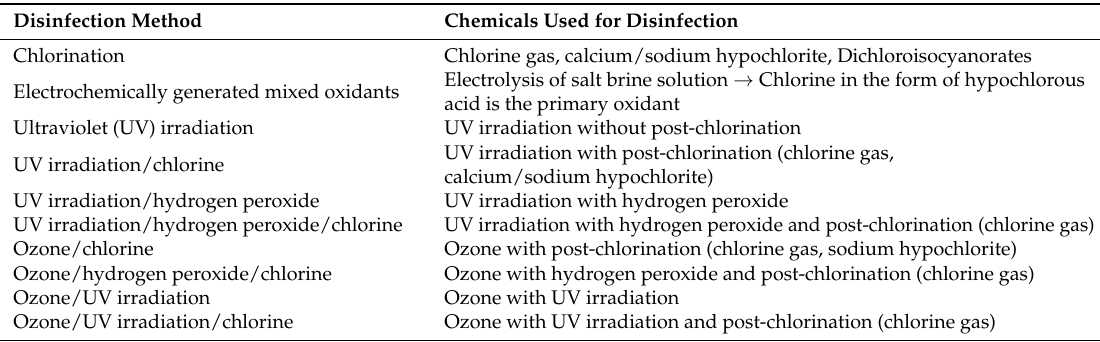
Different methods used for the disinfection of swimming pool water are summarized in Table 1. Table 1. Methods used for the disinfection of swimming pool